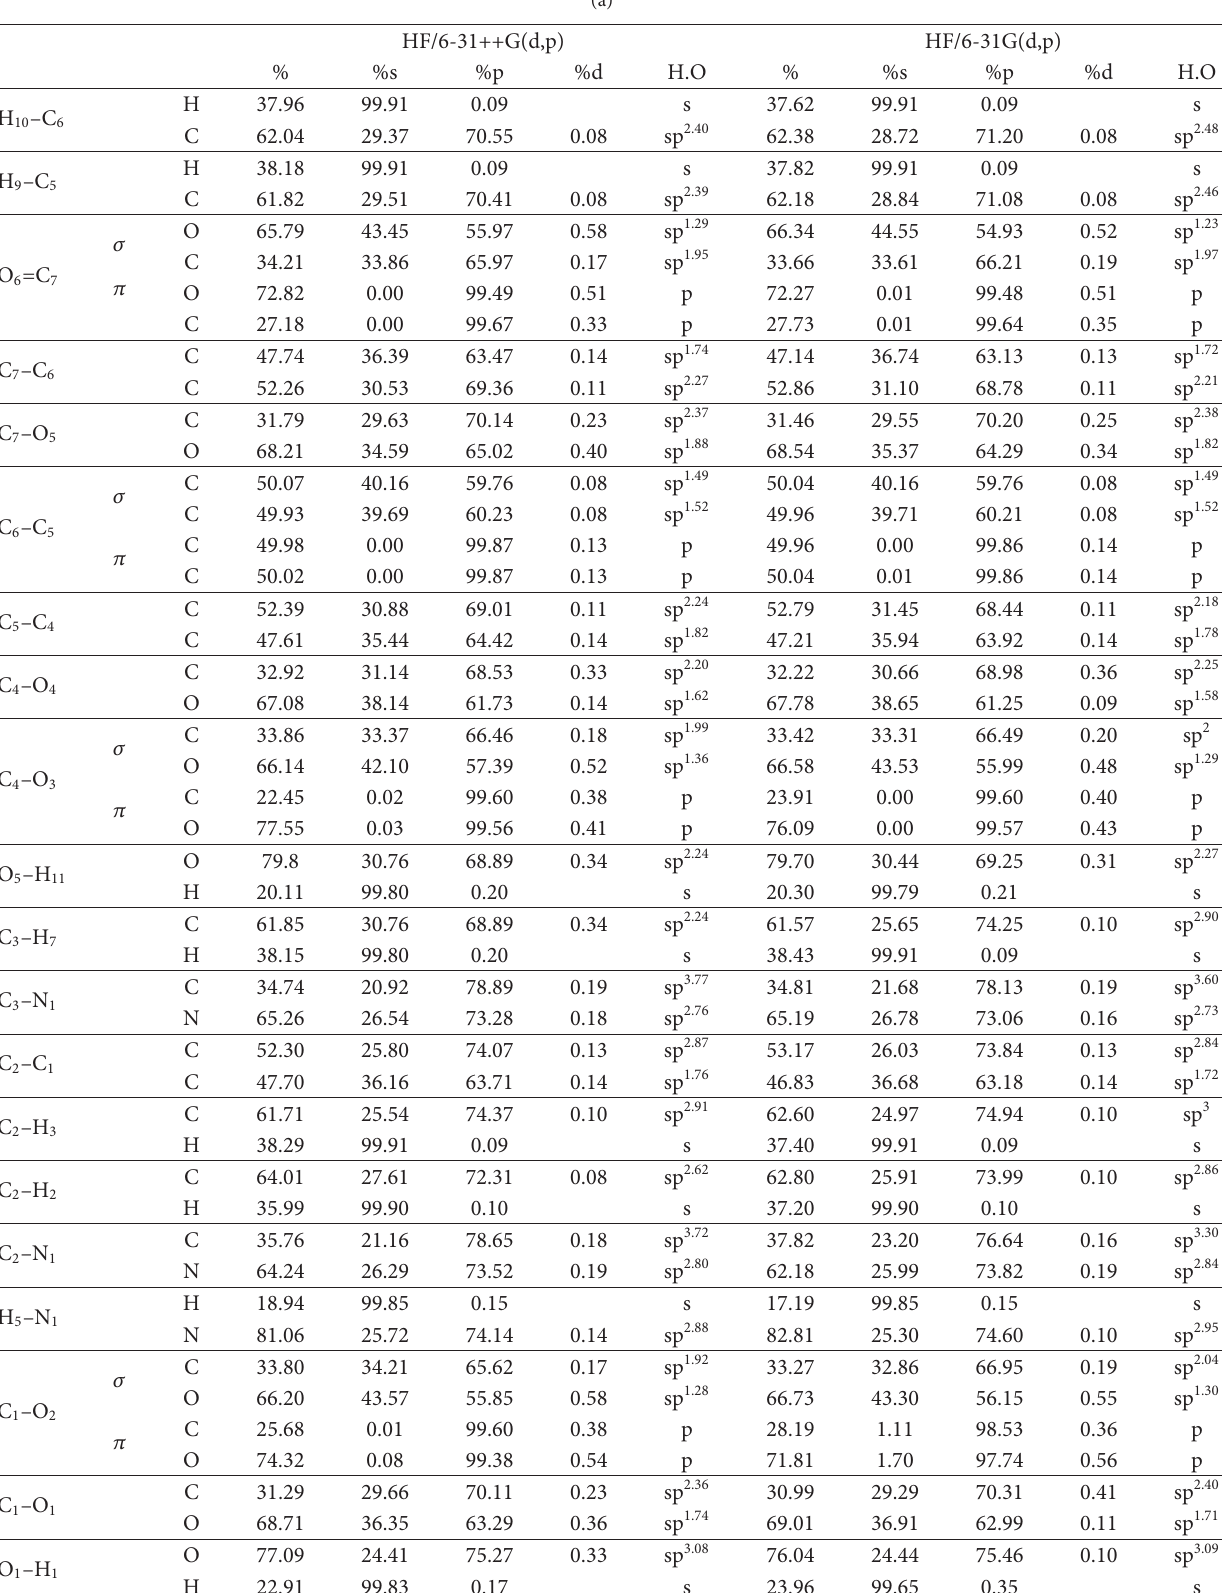
T 3: (a) Selected NBO results showing formation of Lewis and non-Lewis orbitals for sarcosine-maleic acid by using the HF method with 6-31++G(d,p) and 6-31G(d,p) basis sets. (b) Selected NBO results showing formation of Lewis and non-Lewis orbitals for sarcosine-maleic acid by using the B3LYP method with 6-31++G(d,p) and 6-31G(d,p) basis